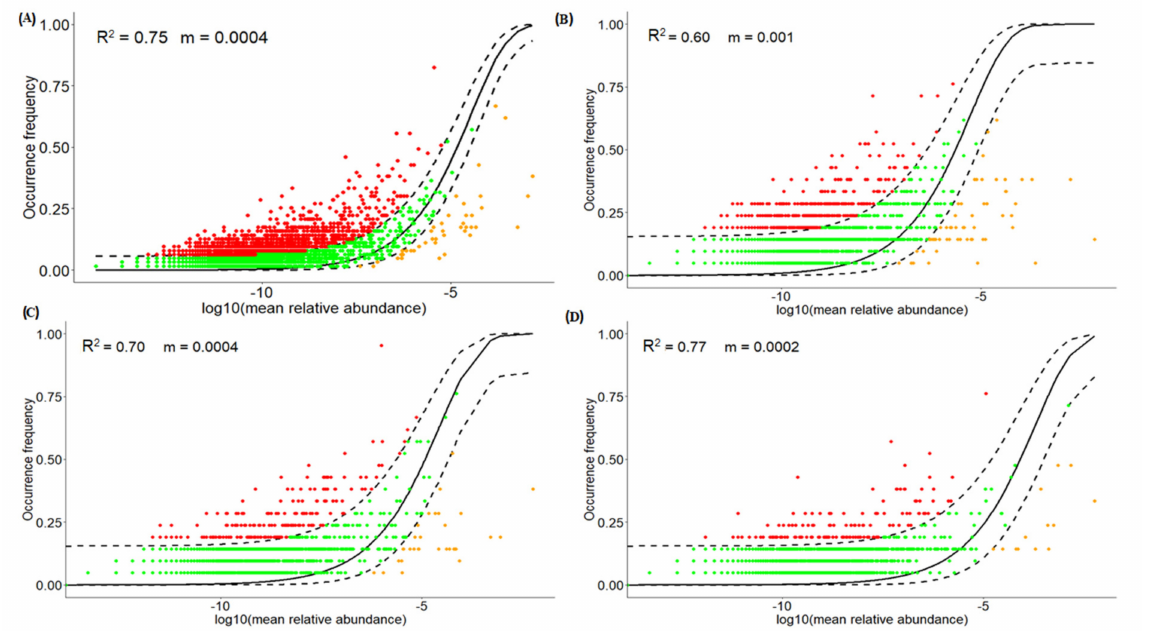
Figure 4. Fit of occurrences frequency of different fungal OTUs as a function mean relative abundance applying Sloan’s model [35]. Red and yellow dots indicate more or less frequently than given by the model. Green dots between dashed lines indicate 95% confidence intervals of the model. R 2 denotes fitness of model, R 2 > 0.2 fitness of model more, m indicates migration rate. ( A ) Overall community, ( B ) surface layer, ( C ) middle layer, ( D ) deeper